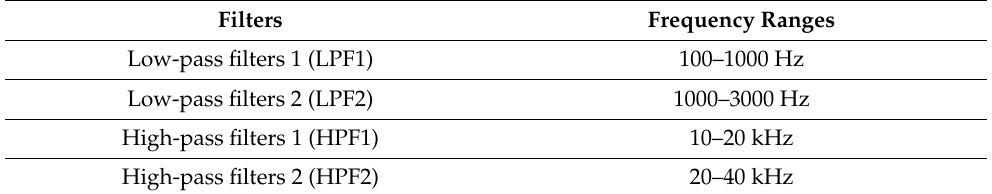
Table 5. Frequency range of the